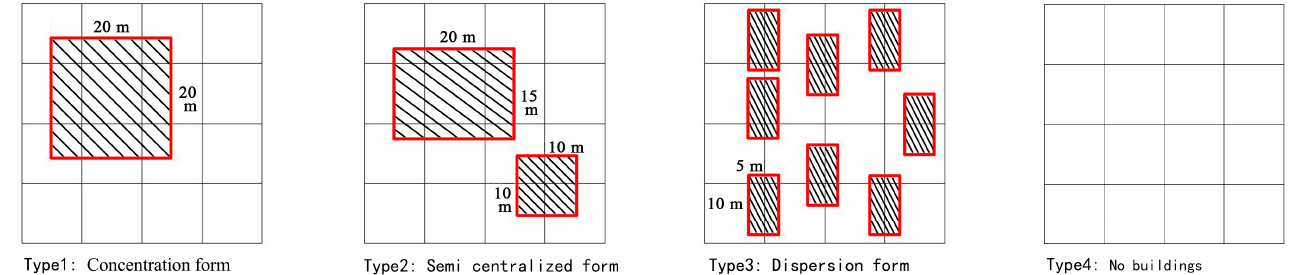
Figure 2. The basic model of the 2D building.